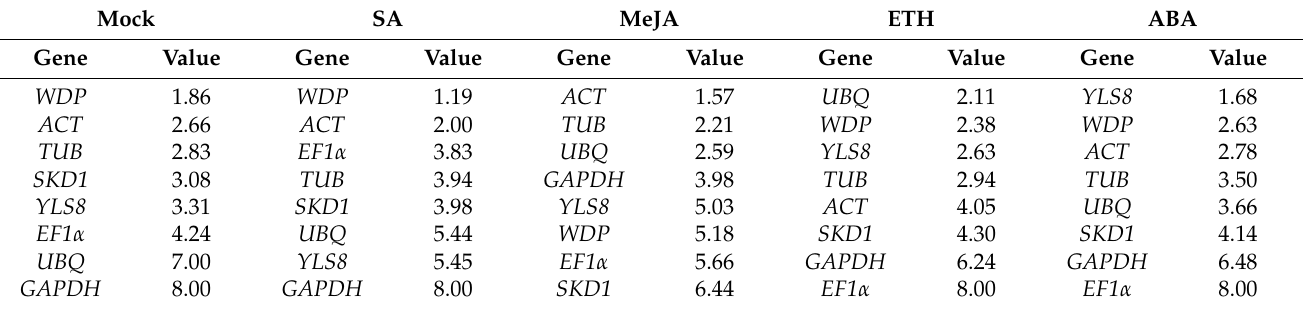
Table 3. Rankings of the expression stability of the eight candidate reference genes in pears under control conditions and hormone treatments, with Cq values being calculated in